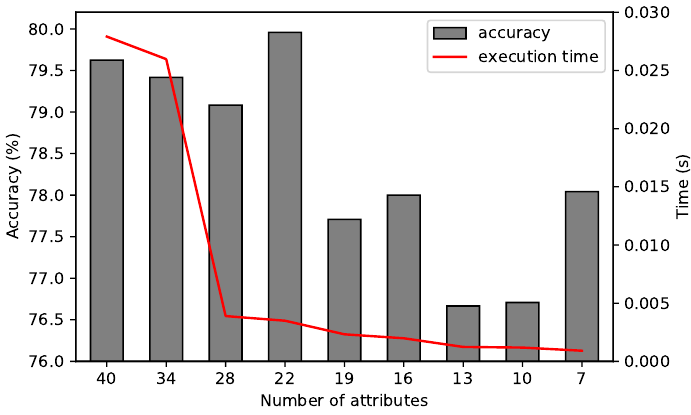
Figure 8. Accuracy and execution time on different feature